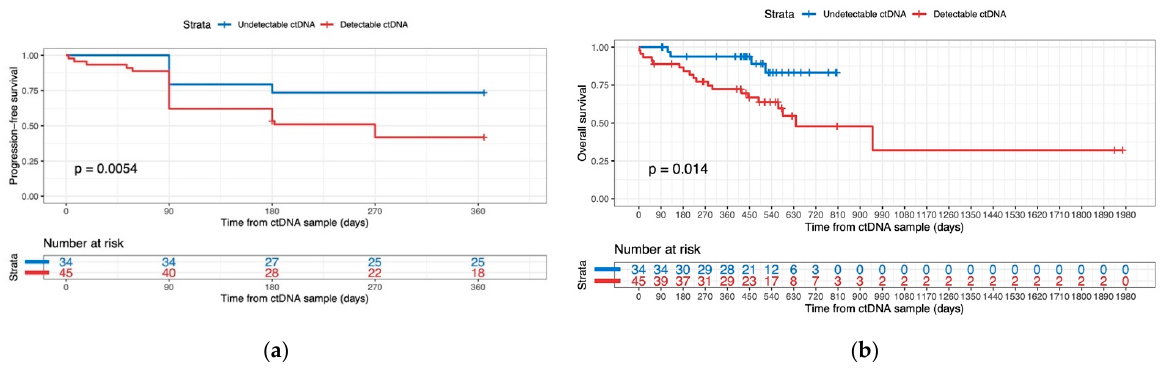
Figure 5. Comparison of detectable vs undetectable ctDNA at the time of the first plasma sample in regards to PFS ( a ) and OS ( b ). p -values were determined with log-rank tests. To compare associations between detectable ctDNA, routine blood markers, known clinical prognostic factors, PFS, and OS, we calculated a multivariate Cox regression model (Table 2). Table 2. Multivariate Cox model for progression-free and overall survival, including ctDNA detec- tion, routine blood markers 1 , and clinical factors 2 .